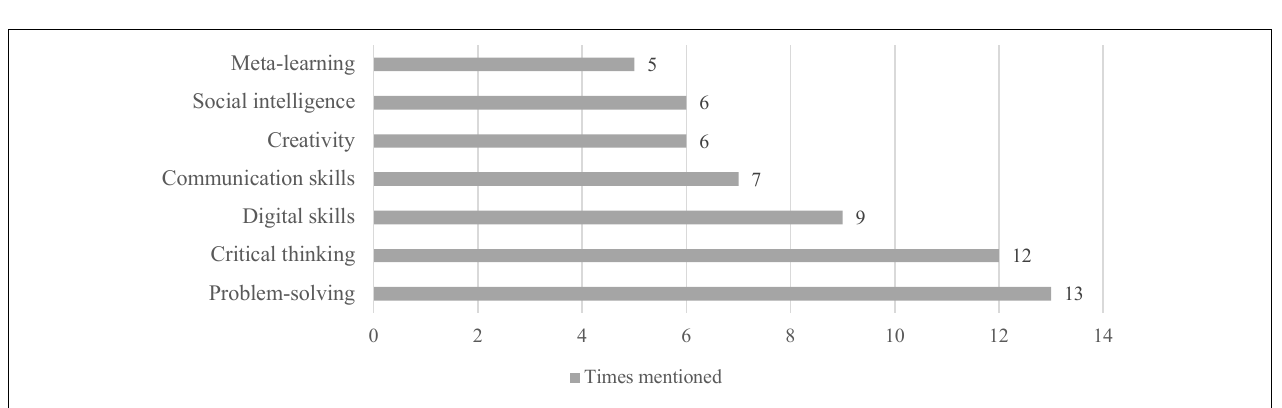
FIGURE 4 | Future challenges.